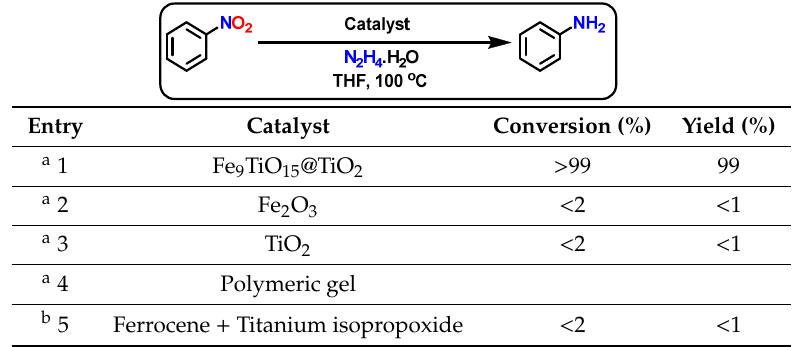
Table 1. Reduction of nitrobenzene: activity of catalysts.